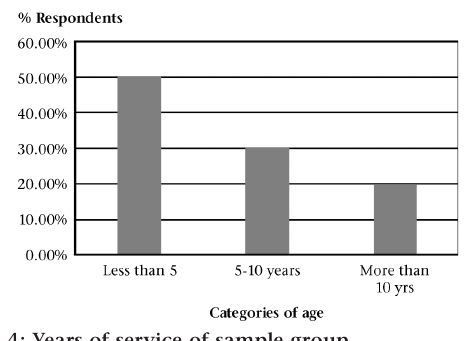
Figure 4: Years of service of sample group